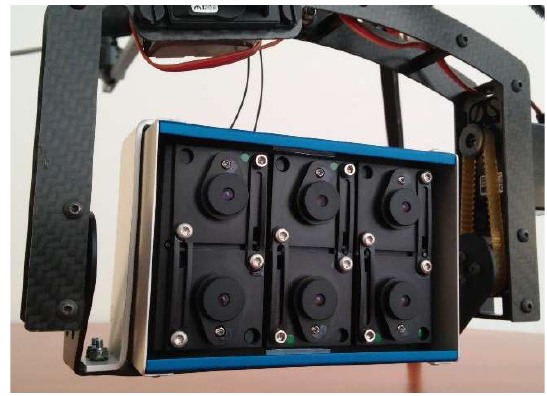
Table 1. Technical parameters and the band composition of the used camera